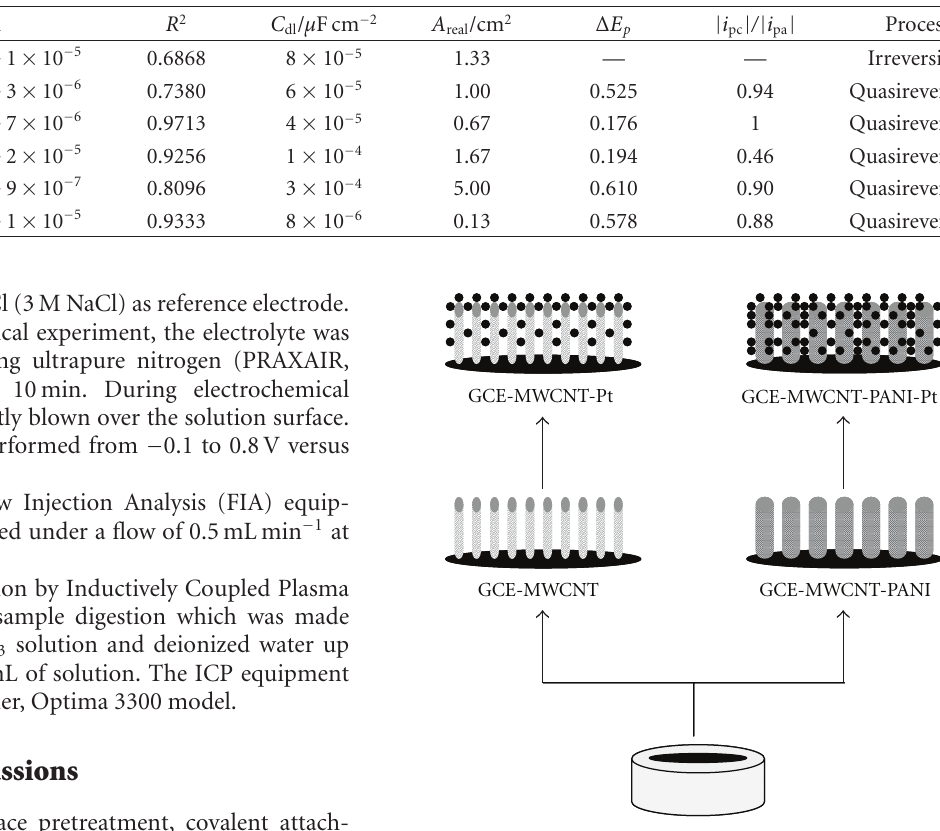
Table 1: Real area values obtained from capacitance current calculations of the di ff erent electrodes, and thermodynamic parameters of the electroreduction of iron over the di ff erent electrodes used, in 0.1 M KCl at 298K: (A) Glassy Carbon Electrode, (B) Glassy Carbon